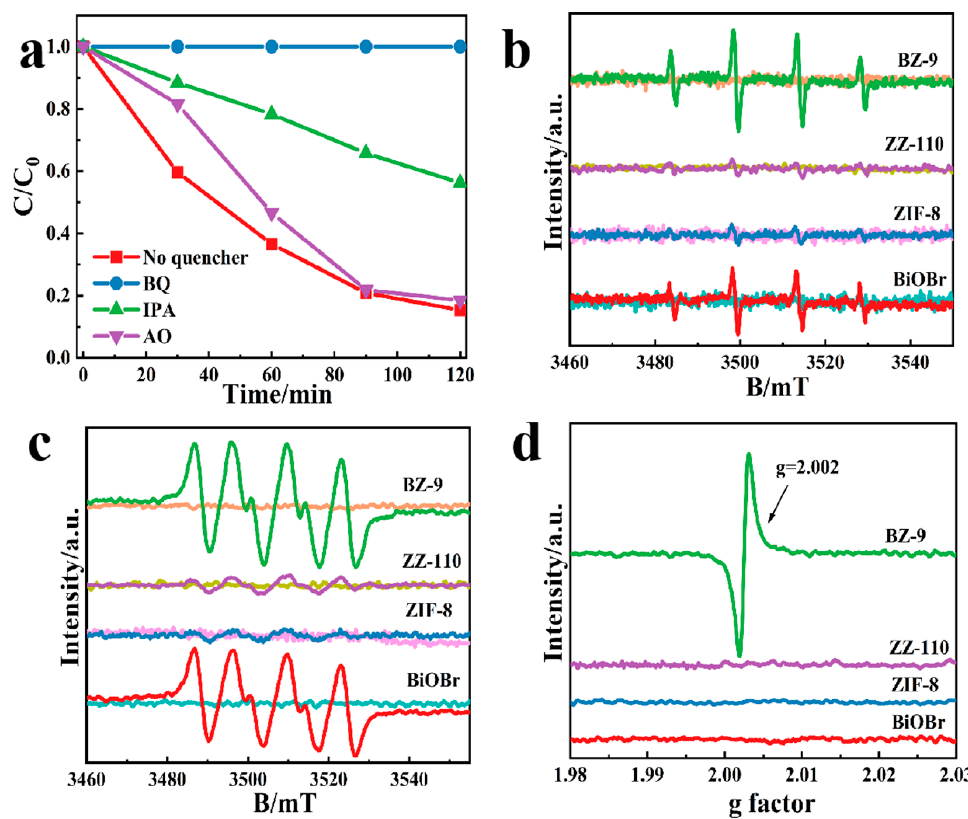
Figure 8. Photocatalytic degradation efficiency of BZ − 9 with or without quenching agent under the illumination of LED lamp ( a ); ESR spin − trapping ∙ OH radicals ( b ); ∙ O 2 − radicals ( c ), and EPR spectrum of OVs ( d ).